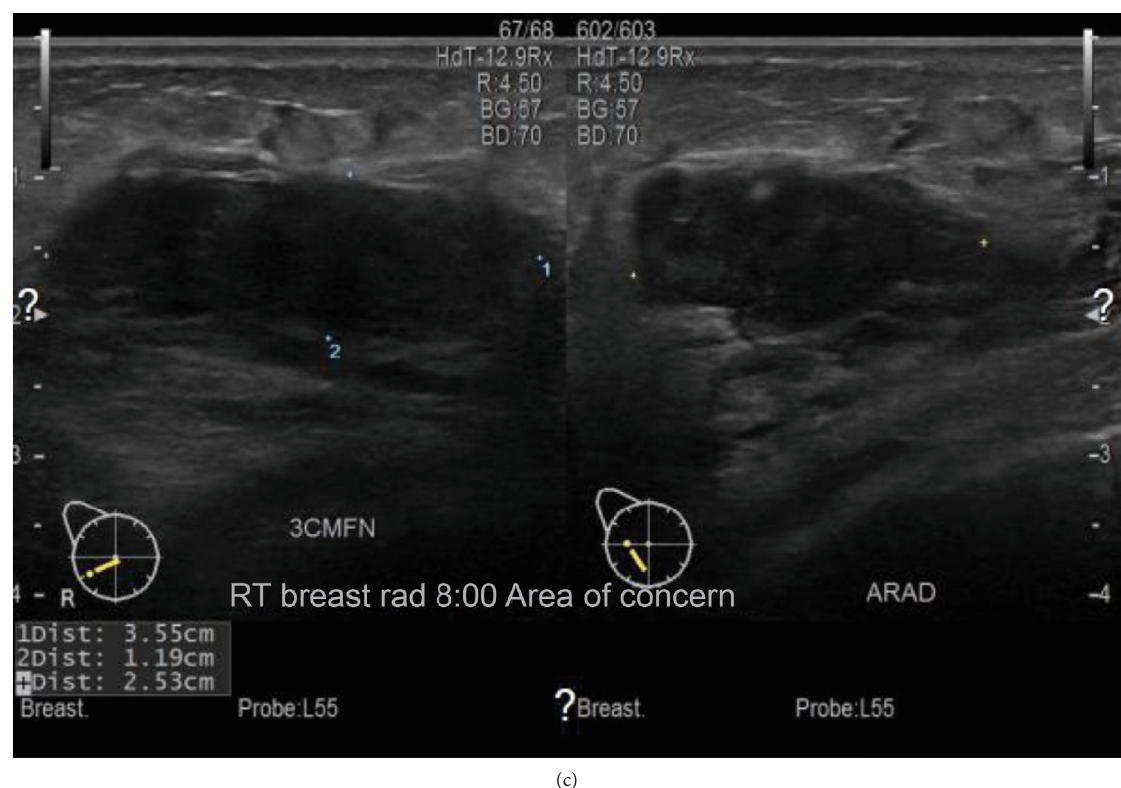
Figure 1: (a – c) Ill-de fi ned mass at 8 o ’ clock position 3cm from the